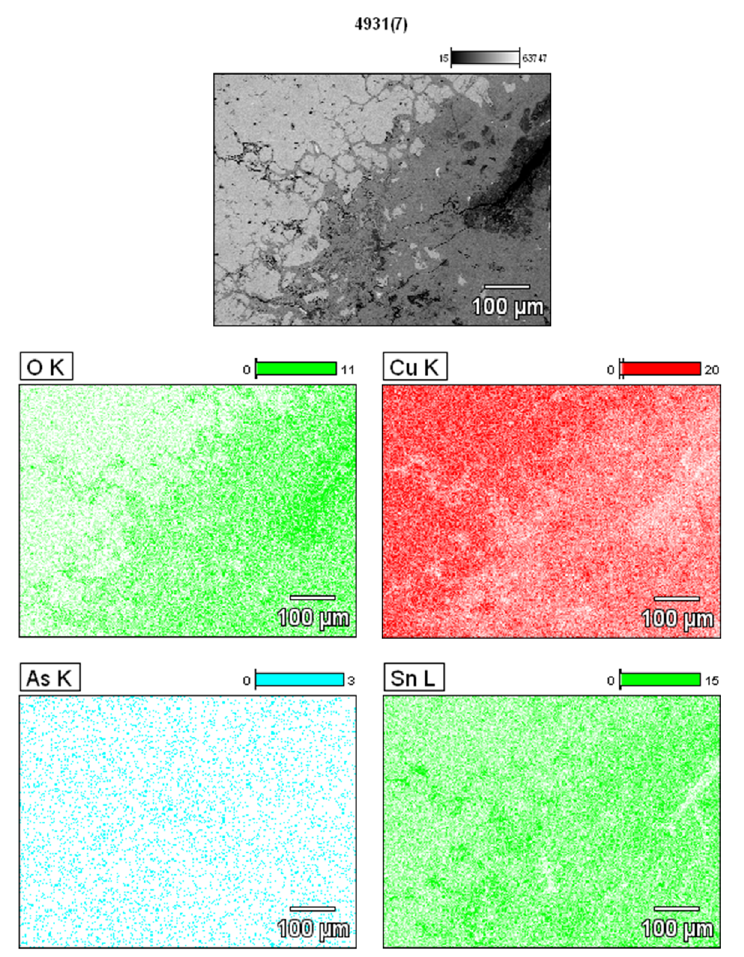
Figure 3. Elemental map of the alloy components from the sample of the neck collar (LMN 4931) from Rehlingen, Lüneburg, Lower Saxony (scan: Dirk Kirchner, German Mining Museum, Bochum).